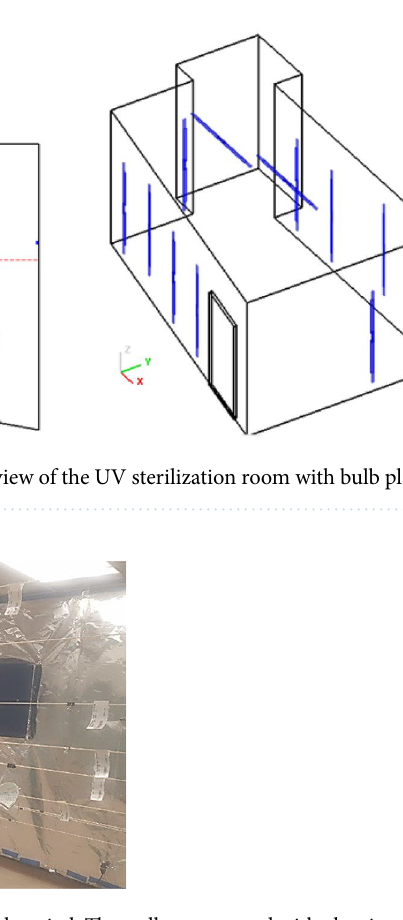
Figure 3. Picture taken of the sterilization room at hospital. The walls are covered with aluminum foil, and facemasks are strung on several different lines across the